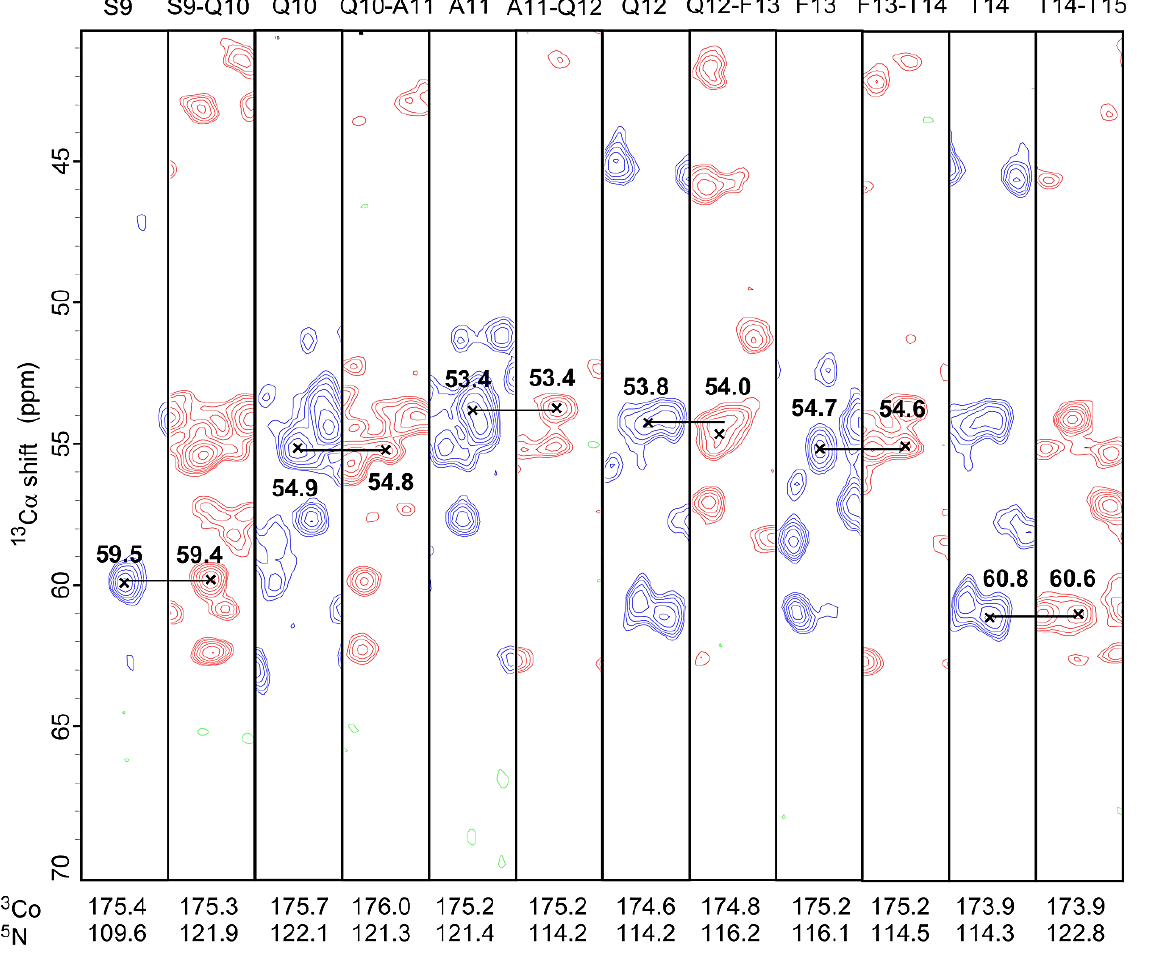
Figure 6. Representative strip plots of residues 9-15 from U-gVp/NA-DNA complex. Sequential assignments from the 3D spectra of NCACX (blue) and NCOCX (red) are illustrated. Correlations with matching Cα and CO chemical shifts are connected with solid lines.